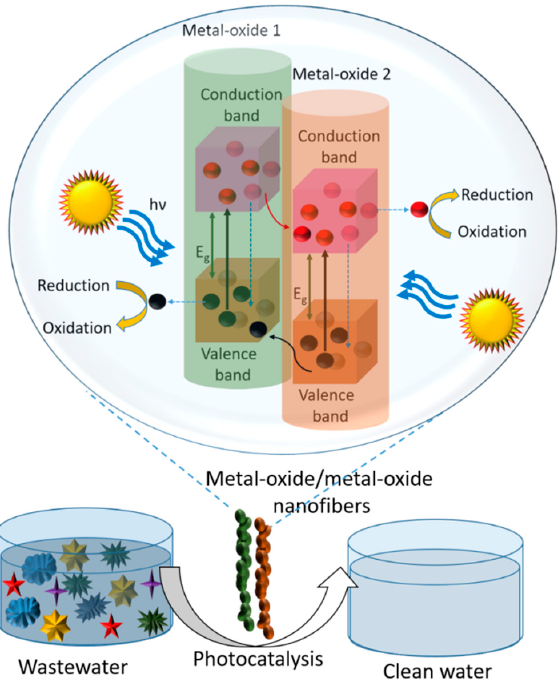
Figure 11. Illustration of charge transfer across the metal oxide–metal oxide nanofiber phase junction and photocatalysis of pollutants.